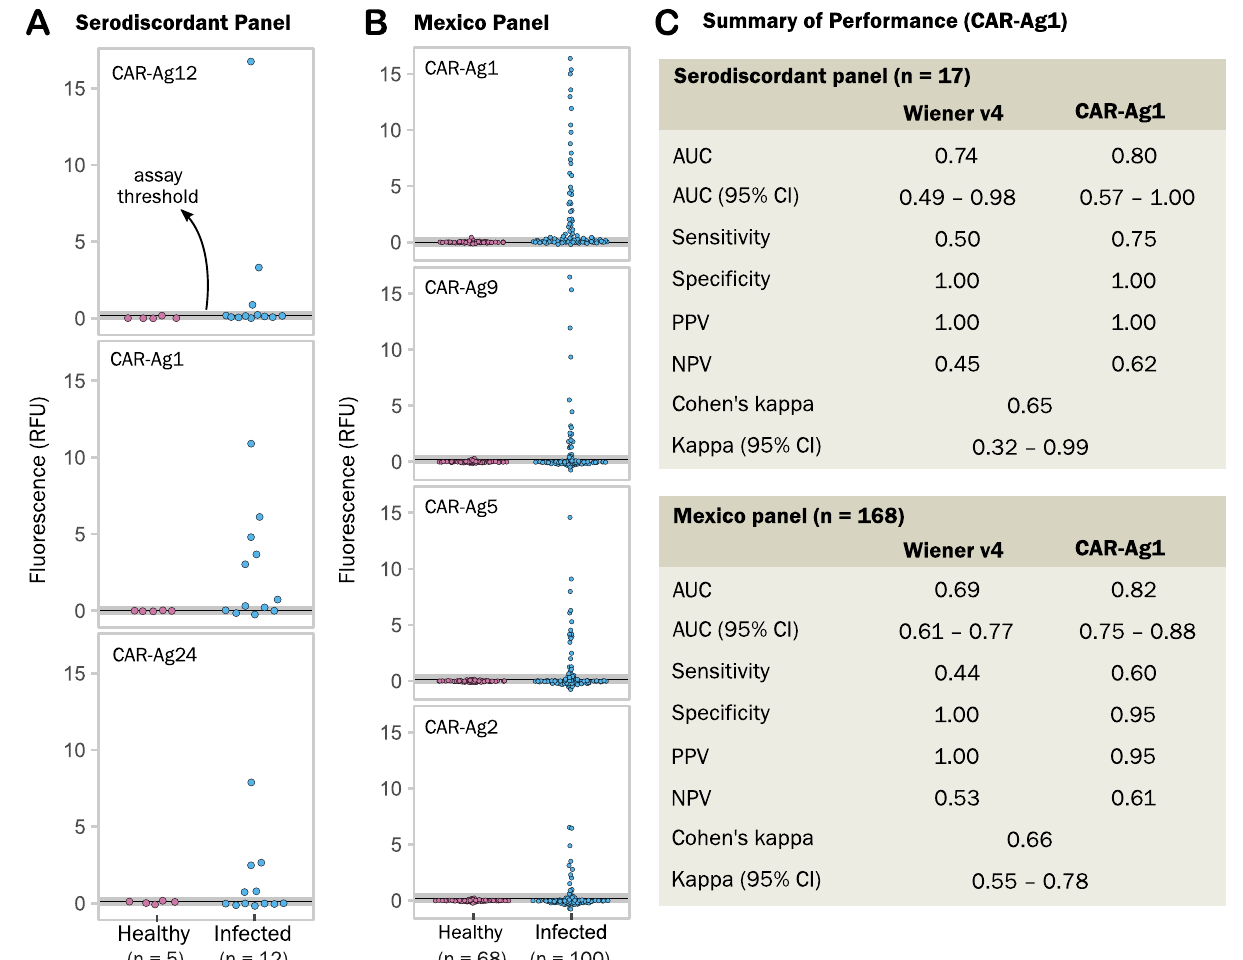
of the con fi rmatory technique (IIF indirect immuno fl uorescence, performed with replicates ina referencecentrebytrained personnel). B Reactivity of fourantigens against a panel of samples from Mexico. Individuals were classi fi ed into Healthy vs Infected using both serology and molecular tests at the origin. C Performance of the CAR-Ag1 antigen against the Wiener Chagatest recombinant v4 assay. Cohen ’ s kappa index measures concordance between the two assays in each panel. Source data for each panel are provided as a Source Data fi